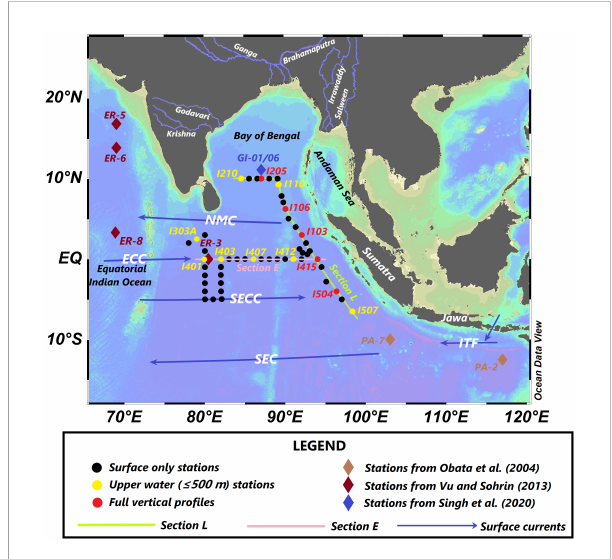
FIGURE 1 Maps presenting sampling stations during the cruise carried out in the spring inter-monsoon period of 2017. Maps also show schematic surface water circulation (blue arrow, deduced using the Ocean Surface Current Analysis Real-time (OSCAR) third-degree (1/ 3 × 1/3 degree) resolution ocean surface current data (ESR, 2009) during the sampling in the study region. NMC, Northeast Monsoon Current; SECC, Southern Equatorial Counter Current; SEC, Southern Equatorial Current; ECC, Equatorial Counter Current; ITF, Indonesian Through fl